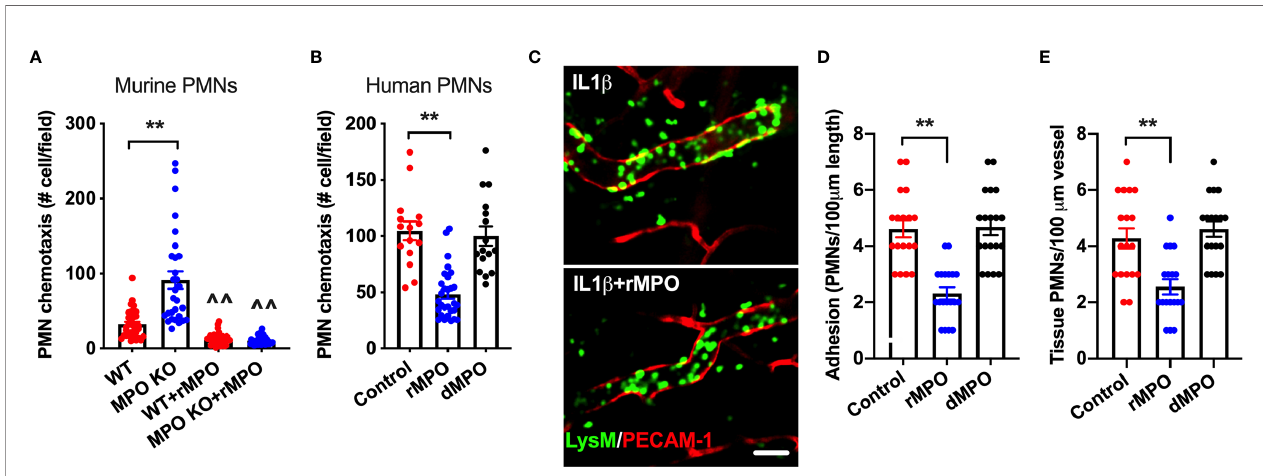
FIGURE 7 | MPO impairs ex vivo and in vivo PMN migration. (A, B) To test whether MPO-mediated impairment of PMN adhesion resulted in inhibition of PMN migration, ex vivo chemotaxis assays using transwells and murine BM-derived and human blood PMNs were performed. For all conditions PMNs chemotaxis was induced by the addition of fMLF to the bottom chamber. (A) Chemotaxis of MPO KO murine PMNs was signi fi cantly elevated compared to WT cells and was signi fi cantly suppressed with the addition of rMPO (20µg/ml). (B) Similarly, migration of human PMNs was inhibited by the addition of rMPO. N=5 independent repeats in triplicates. (C, E) IVM on the cremaster muscle in LysM-eGFP reporter mice (green PMNs) was performed to assess the impact of rMPO administration on PMN adhesion and TEM. In fl ammation of the cremaster muscle was induced by intrascrotal administration of IL-1 b (50ng, 4hr). rMPO (30µg in 100ml of sterile PBS) was administered retro-orbitally immediately following IL-1 b stimulation. A signi fi cant reduction in (D) PMN adhesion and (E) TEM (extravasated PMNs in the tissue) was seen. The bar is 50µm. N=5 mice per condition with 3-5 randomly selected fi elds. **p < 0.01, ^^ signi fi cantly different from non-treated controls, p <